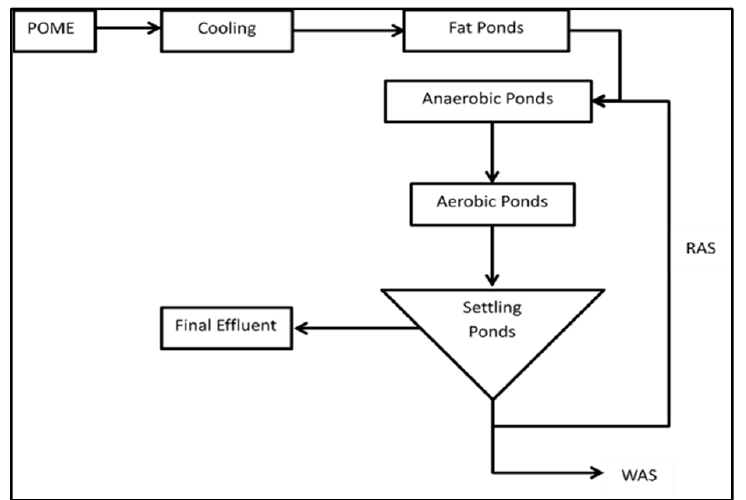
Figure 4. POME treatment scheme using conventional technology (open pond system). Adapted from ref. [30].